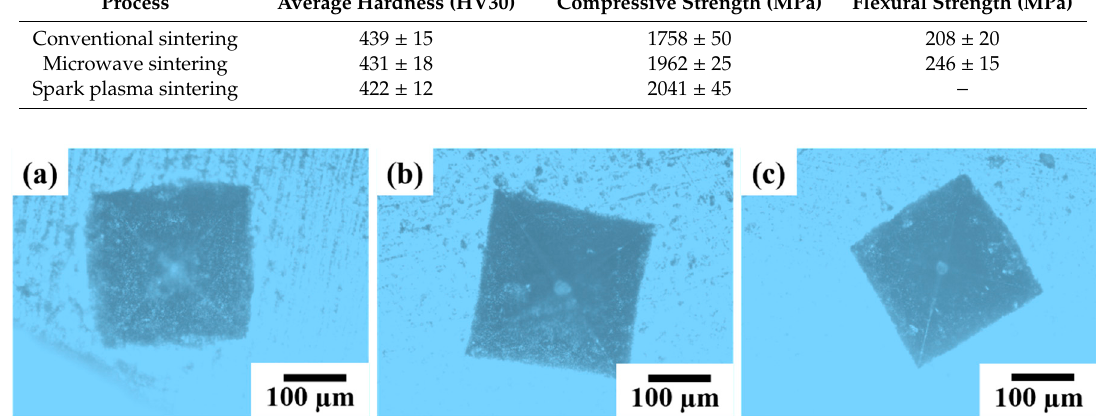
Figure 6. The micrograph of the indents after Vickers microhardness measurement in ( a ) WHHEAC, ( b ) WHHEAM and ( c ) WHHEAS respectively.